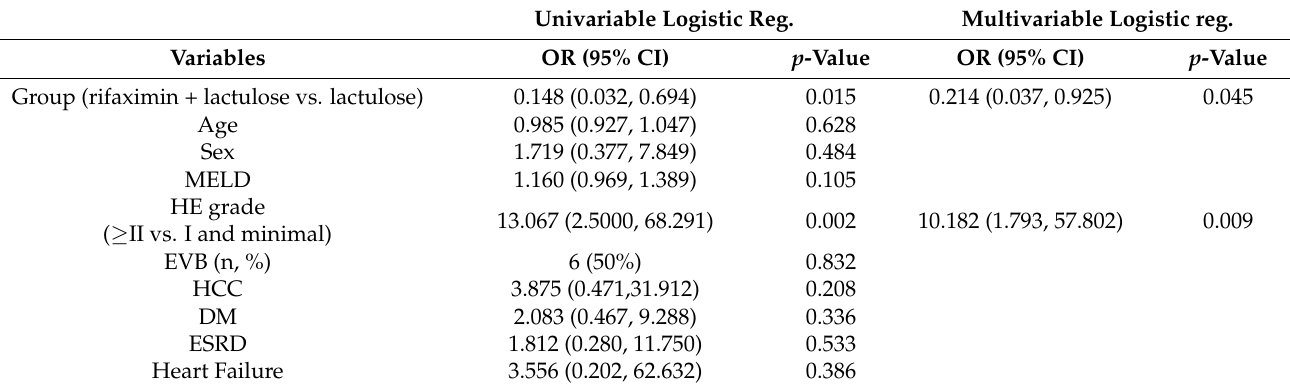
Table 2. Logistic regression estimates of baseline parameters for predicting HE recurrence within 1 year. Univariable Logistic Reg.